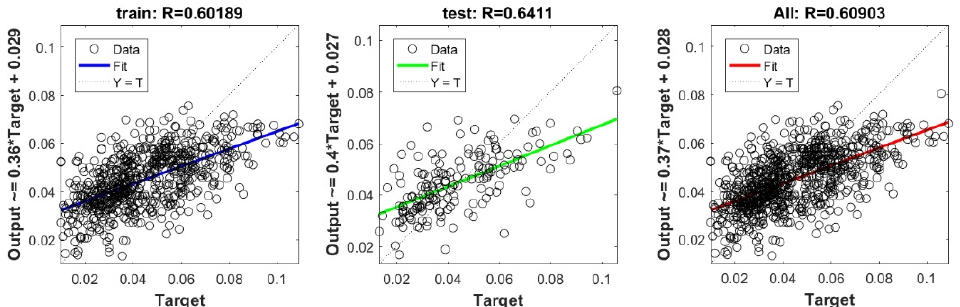
Figure A8. Scatter plots between target and output value by the FS-RF model.